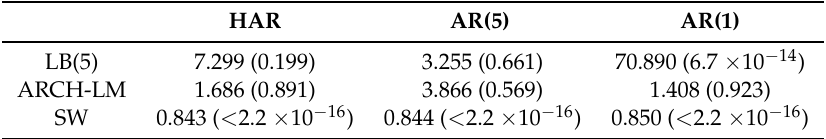
Table 4. (cid:98) L t , in-sample residual diagnostic test statistics. LB, Ljung–Box; SW, Shapiro–Wilk.